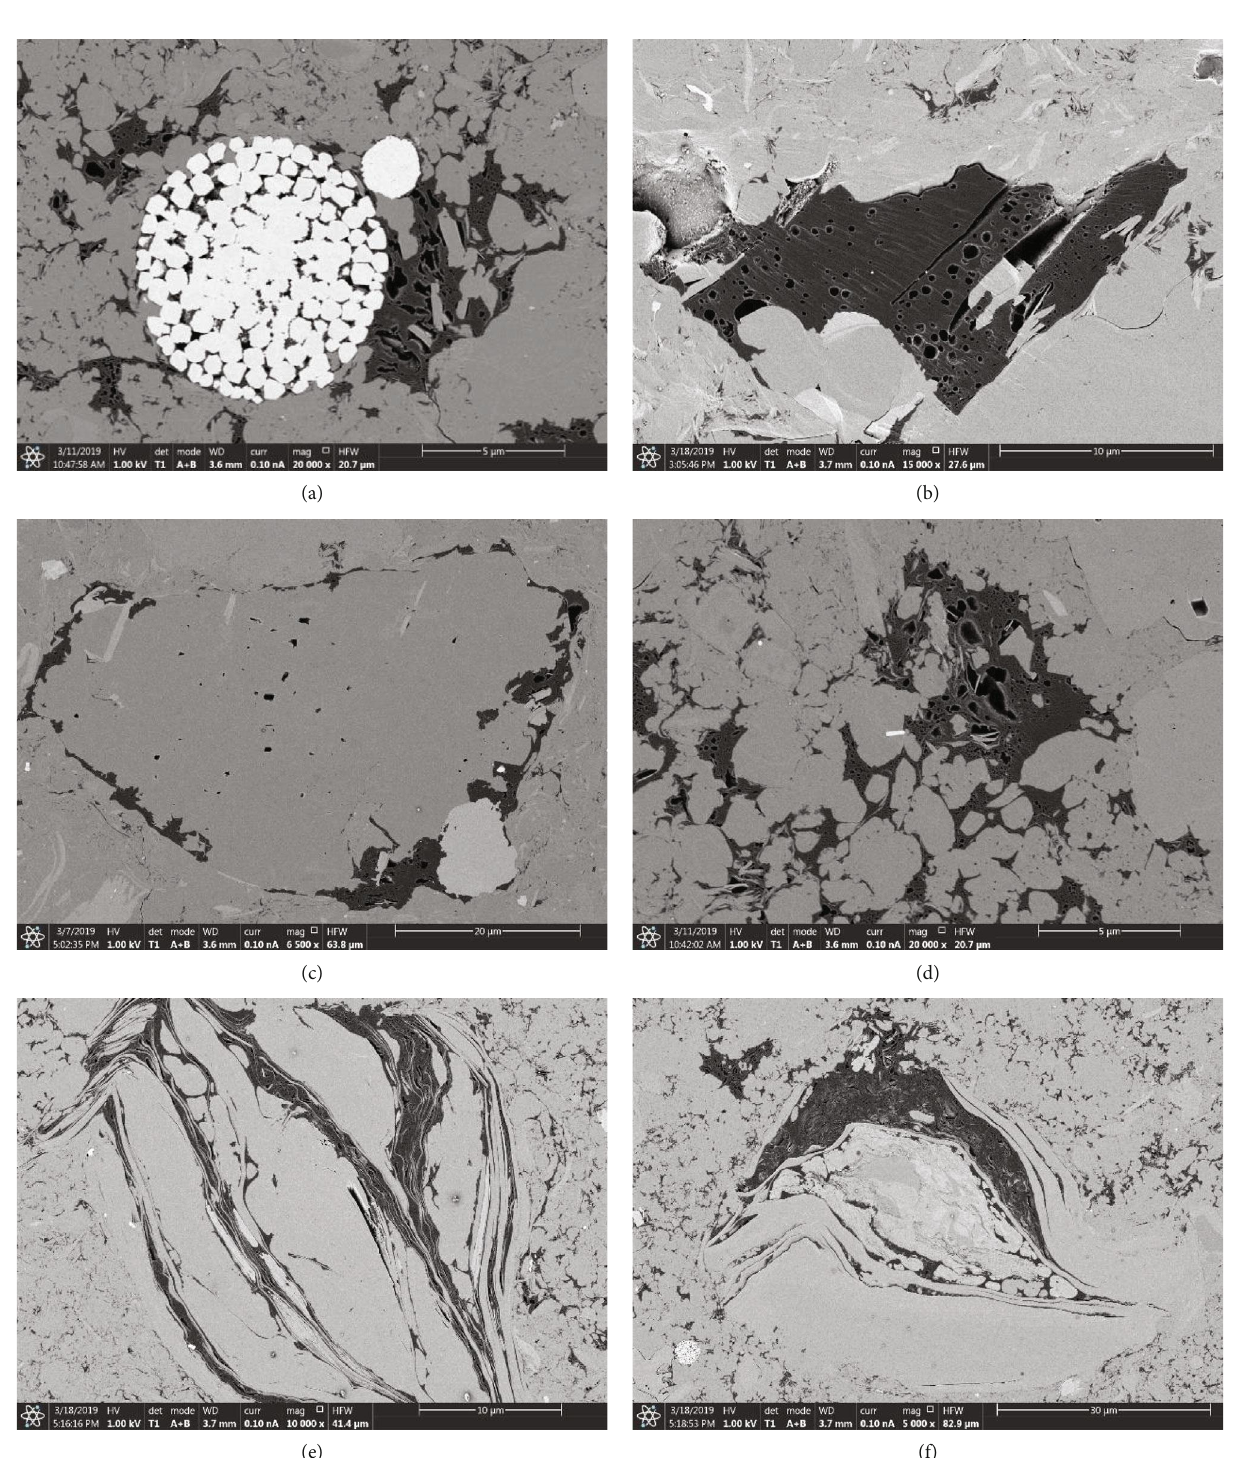
Figure 9: SEM images showing pyrobitumen and related pores in Wufeng-Longmaxi shale samples. (a – d) Pyrobitumen pieces with subround to round pores. Pyrobitumen is associated with minerals having a relatively regular shape and lower brightness. (b) Gas-related round pores with a tail-like structure within pyrobitumen. (e, f) Irregular or deformed pores in pyrobitumen fi lled with minerals of a curved to highly contorted scaly and silk thread laminar